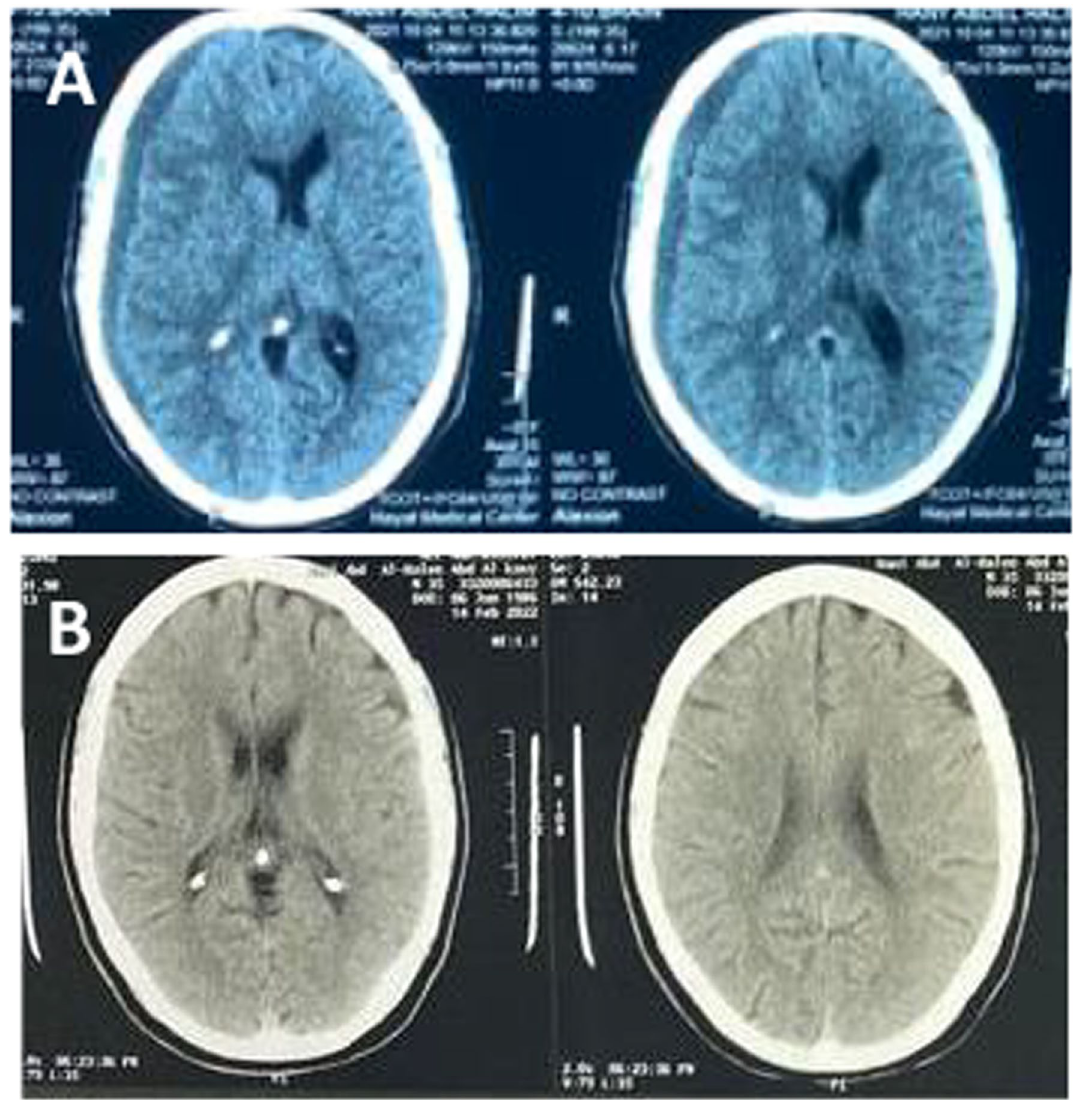
Fig. 2 A Initial CT brain of a 44-year-old male patient presenting with headache, vomiting, hemiparesis and drowsiness, showing a right fronto-parietal CSDH producing a midline shift. B Complete resolution of the hematoma 3 months after initiating dexamethasone treatment